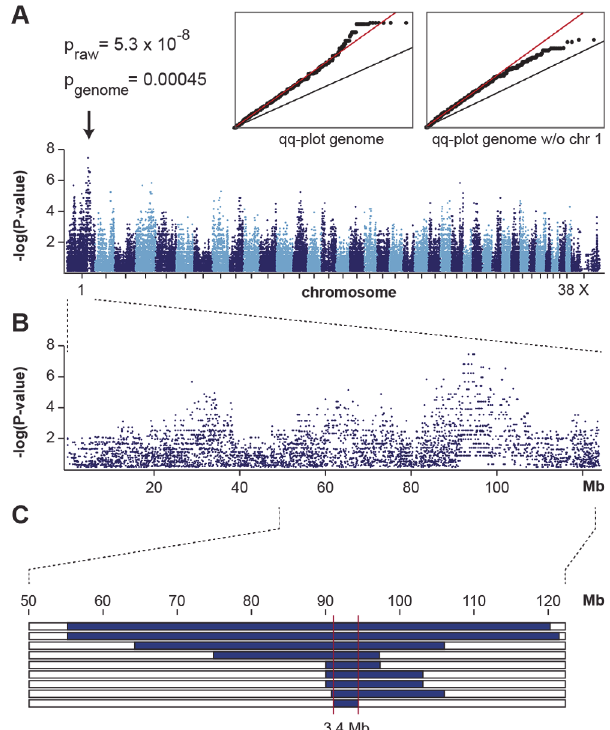
Fig 1. Mapping of DWLM in Eurasier dogs. (A) A genome-wide association study using 9 cases and 11 controls indicates a signal with multiple associated SNPs on chromosome 1. The p-values are inflated due to the use of closely related animals. The inserted quantile-quantile (qq) plots show the observed versus expected log p-values. The straight black line in the qq-plots indicates the distribution of SNP markers under the null hypothesis. The straight red line visualizes the inflation of p-values caused by the close relatedness. This inflation is randomly distributed across the entire genome. The skew at the right edge of the genome- wide qq-plot indicates that several markers on chromosome 1 are stronger associated with DWLM than it would be expected by chance. This skew is absent when chromosome 1 markers are omitted from the plot. (B) The detailed view of chromosome 1 suggests an associated interval of approximately 10 Mb at ~91 – 101 Mb. (C) Homozygosity mapping. Each horizontal bar corresponds to one of the 9 analyzed cases. Homozygous regions with shared alleles are shown in blue. A shared homozygous interval of ~3.4 Mb delineates the exact boundaries of the critical interval from 90,860,923 bp to 94,212,001 bp (CanFam 3 assembly).